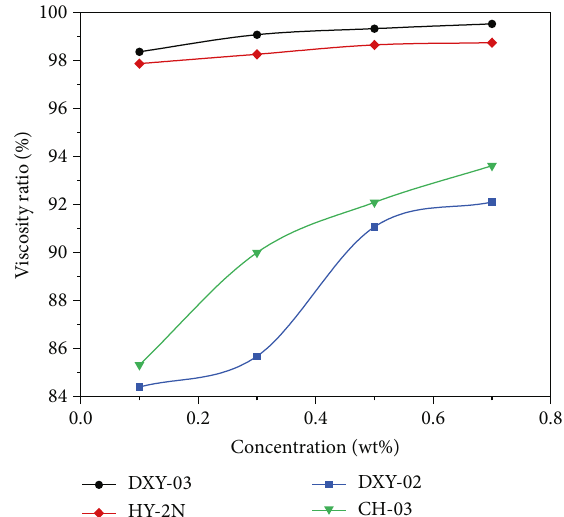
Figure 5: Viscosity reduction curves of four viscosity reducing and foaming